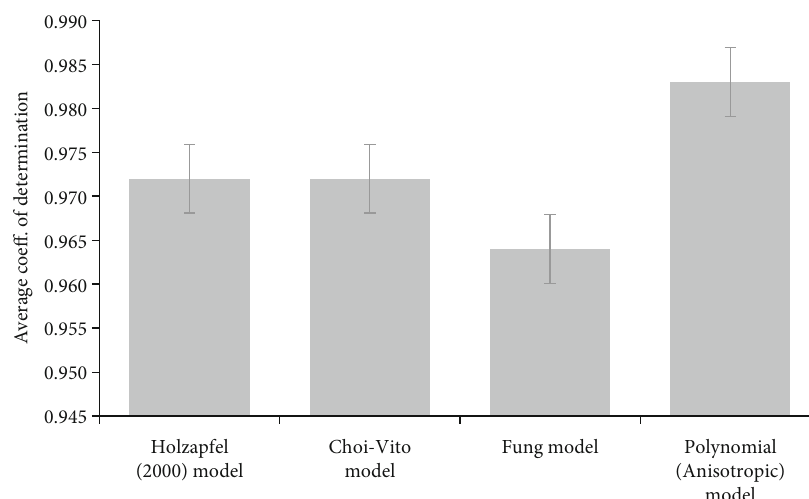
Figure 4: Average coe ffi cient of determination ( R 2 ) (with standard error) of the porcine soft tissue sclera calculated for Holzapfel (2000), Choi-Vito, Fung, and polynomial (anisotropic) hyperelastic constitutive models, with polynomial (anisotropic) constitutive model showing the highest R 2 of 0.983 and the lowest R 2 of 0.964 observed for Fung constitutive model.